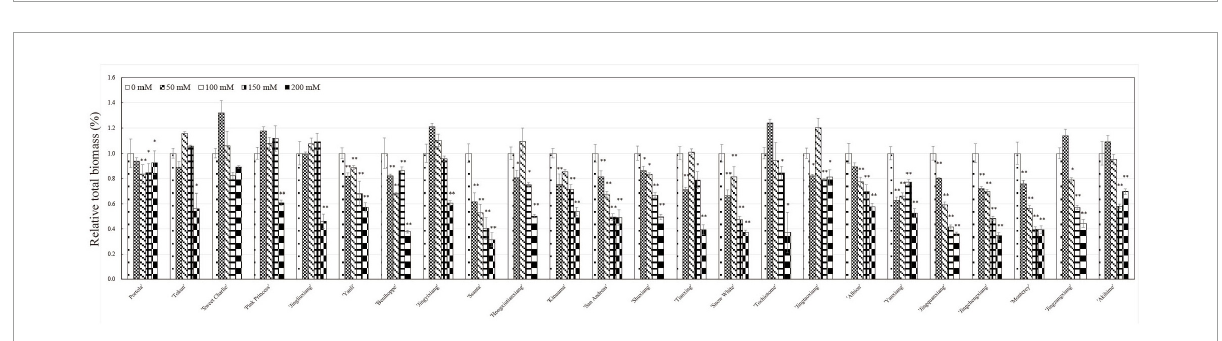
FIGURE2 Relative total biomass of 24 strawberry varieties under different concentrations of NaCl. Strawberry plants with 6–7 leaves were irrigated with five different concentrations of salt solutions: 0, 50, 100, 150, or 200 mM NaCl for 50 days. Relative biomass accumulation was counted as the dry weight of the whole plant treated with different concentrations of salt solutions (50, 100, 150, or 200 mM) divided by the dry weight of the whole plant treated with fresh water. Data are means ( ± SD) of three independent experiments, ∗ p < 0.05 or ∗∗ p <